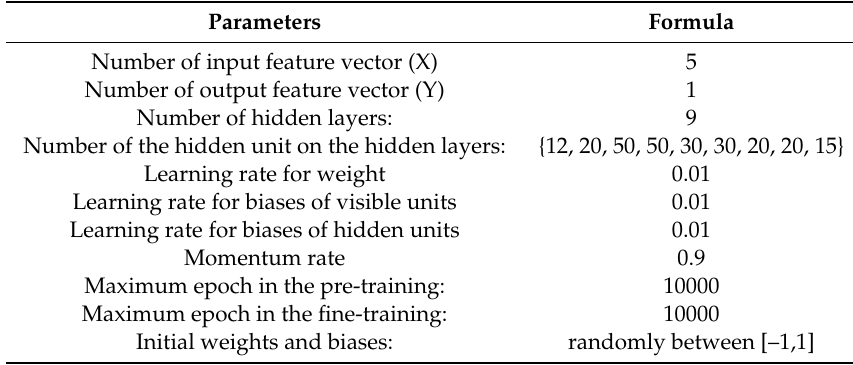
Table 2. Parameter setting of the deep neural